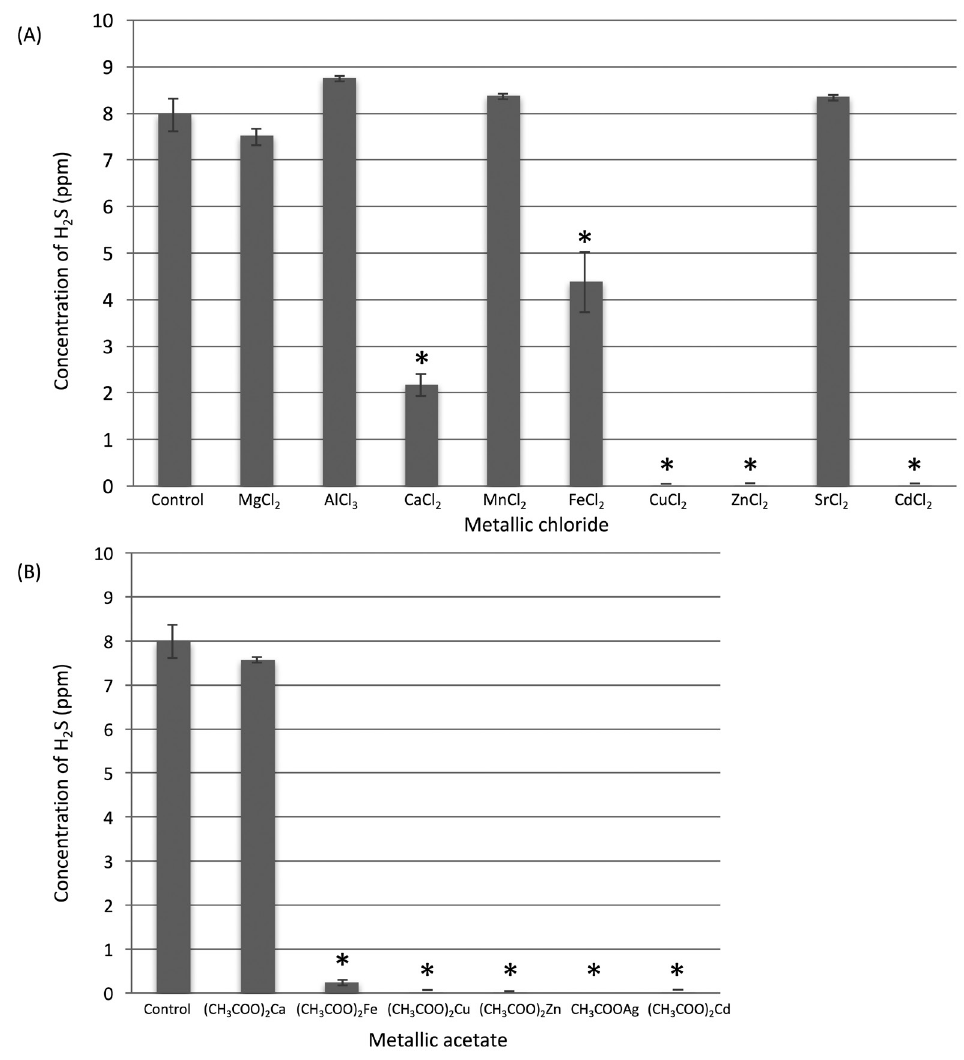
Figure 1- The direct inhibitory effects of aqueous solutions of metal chlorides (A) and metal acetates (B) on gaseous H